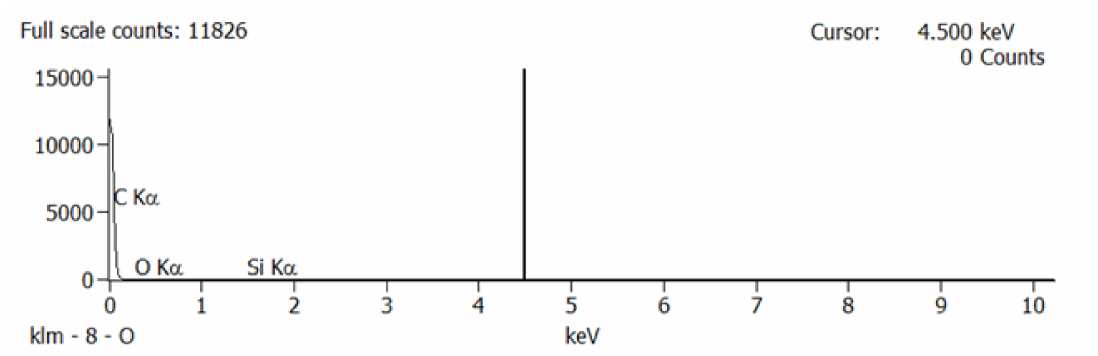
Figure 10. Graphical representation of the EDX analysis presented